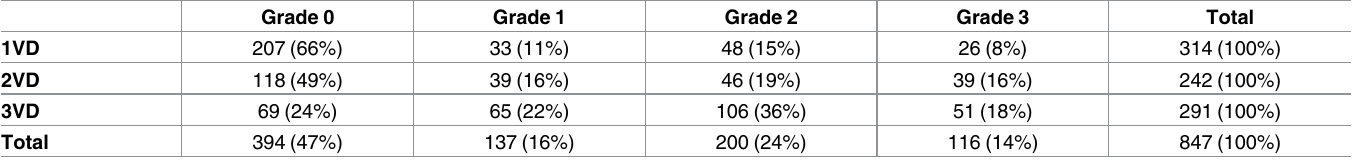
Table 2. The relationship between the extent and severityof CAD and collateralization